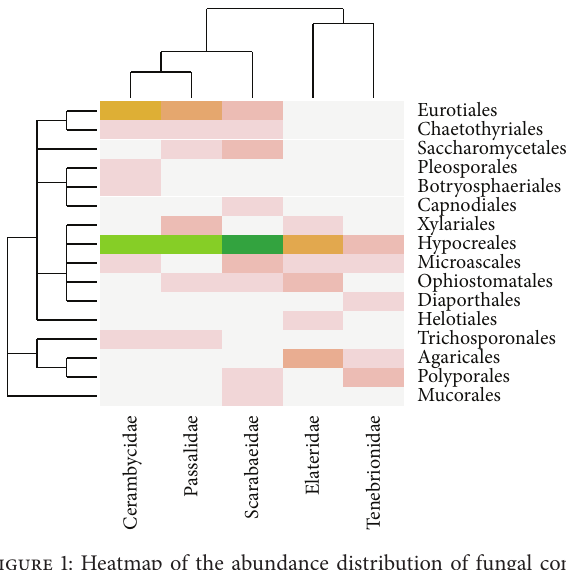
Figure 1: Heatmap of the abundance distribution of fungal com- munities associated with the guts of five wood-feeding families of Coleoptera. The taxonomic relationship of the fungal genera is shown in the rows, while the clustering of the coleopteran families, determined by their composition similarities, is shown in the columns. Higher intensities of the color reveal higher abundances of the